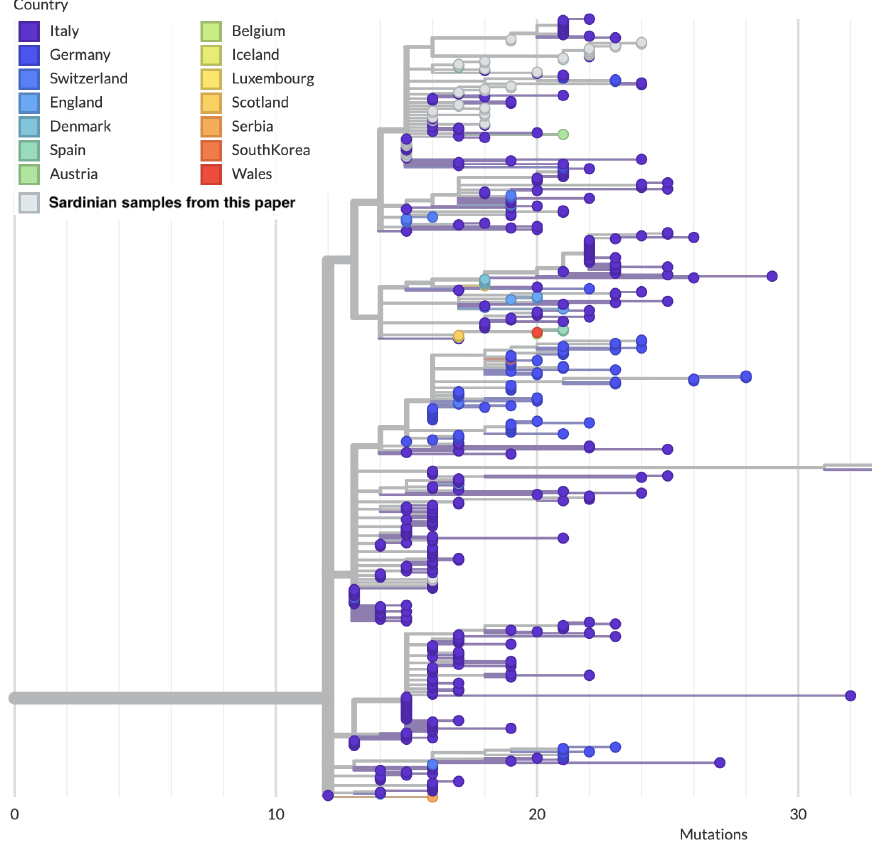
Figure 6. Local subtree generated from Auspice/NextStrain containing 28 out of the 55 Sardinian sequences presented in this wok (white circles). Note how most of the sequences in this subtree, including the most basal one, originate from continental Italy.